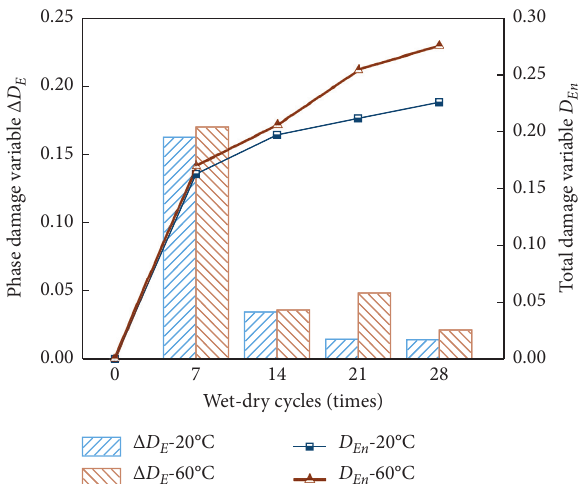
Figure 10: Total damage variable and phase damage variable of RC after being subjected to different wet-dry cycles.